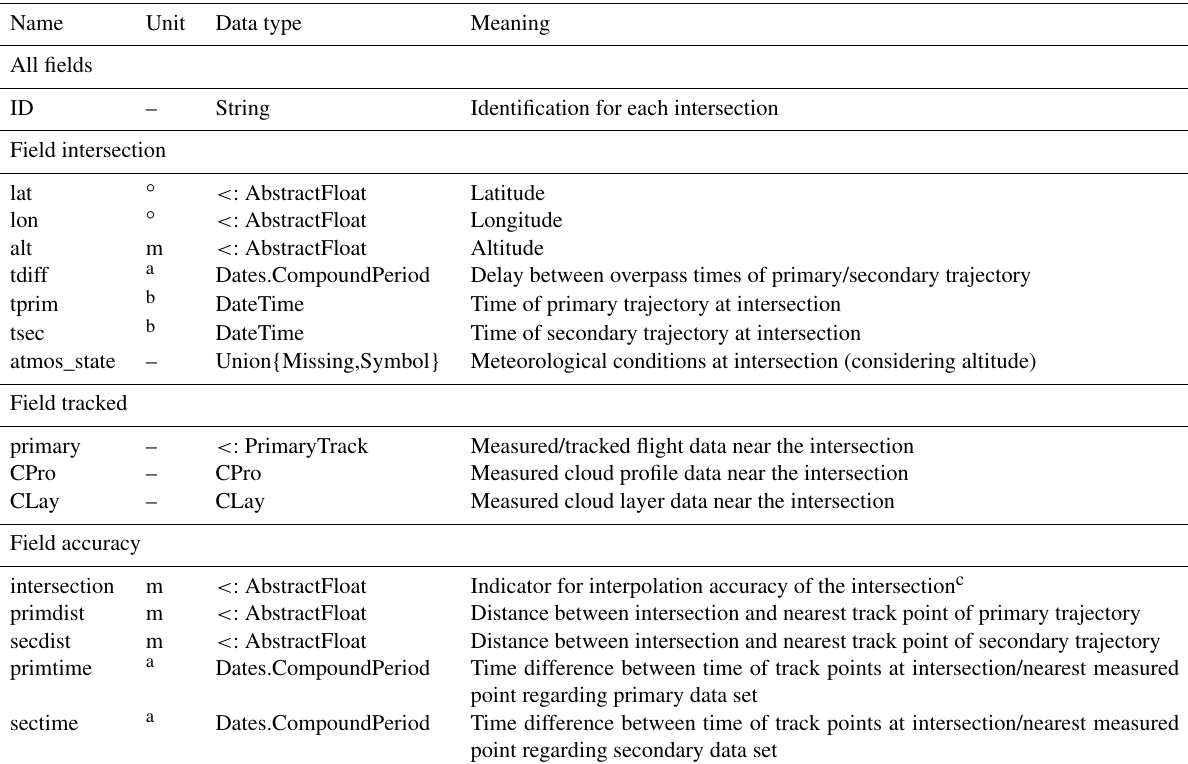
Table 2. Column names in the DataFrames of the Intersection fields together with the corresponding data types and